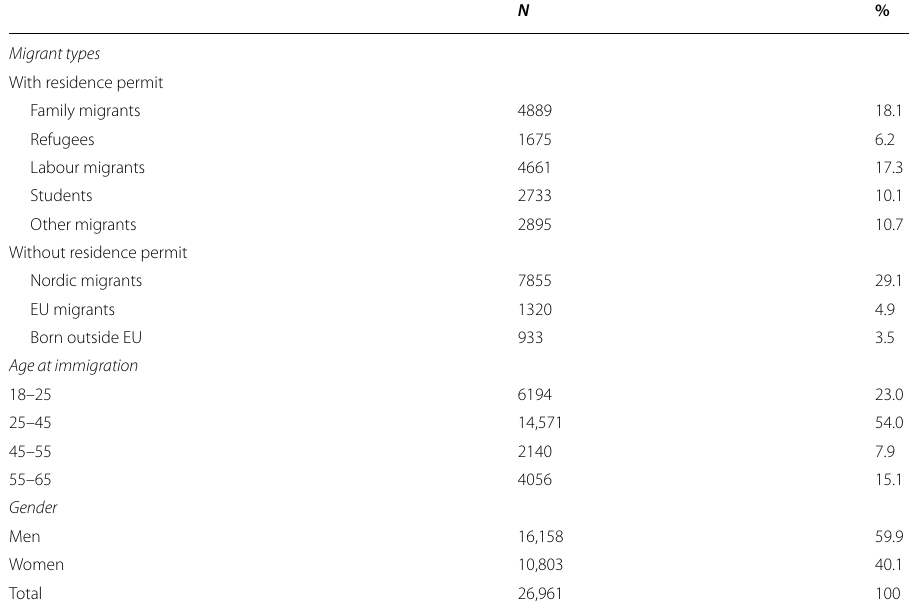
Table 4 Descriptive statistics on the censored population